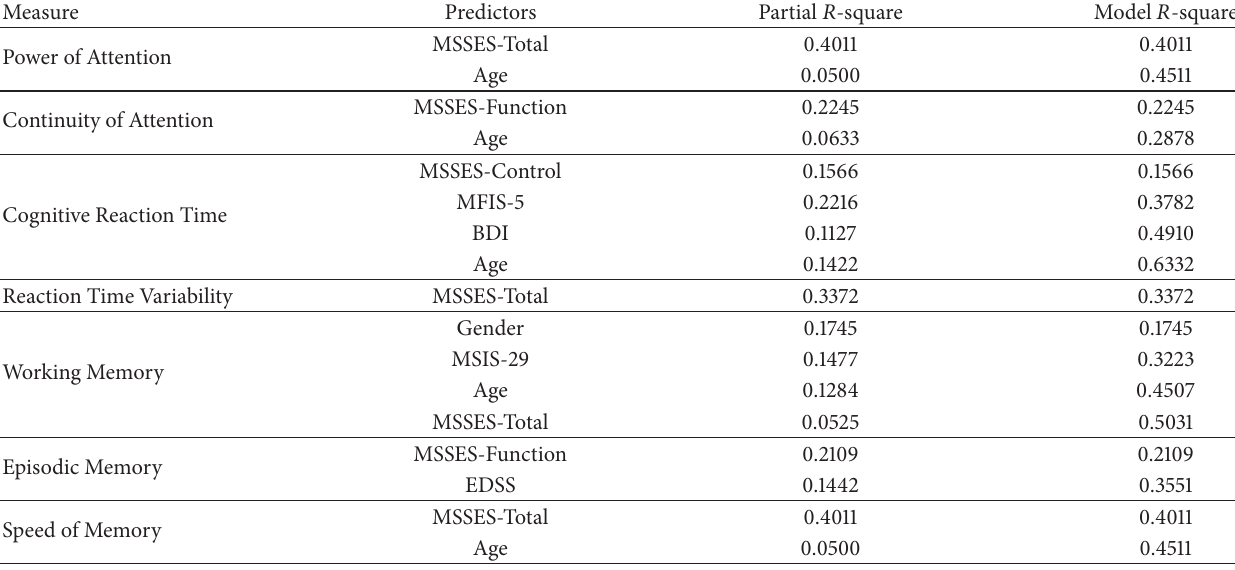
Table 3: Multivariate prediction of cognitive domain scores in persons with CIS and eRRMS ( 𝑁 = 33 ).